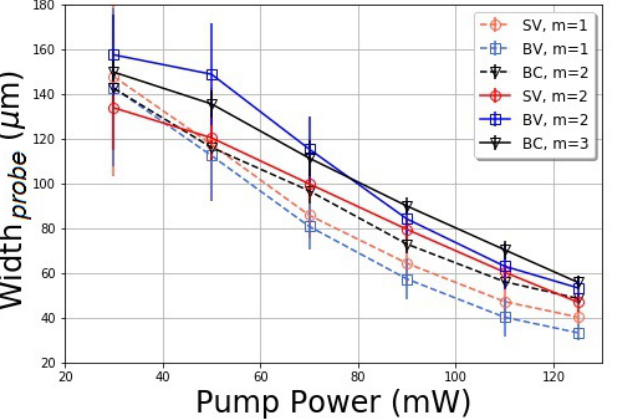
Figure 5. Measured diameter of the probe output versus input pump power for the singular structures in Figure 2b, with winding numbers as specified in the legend.